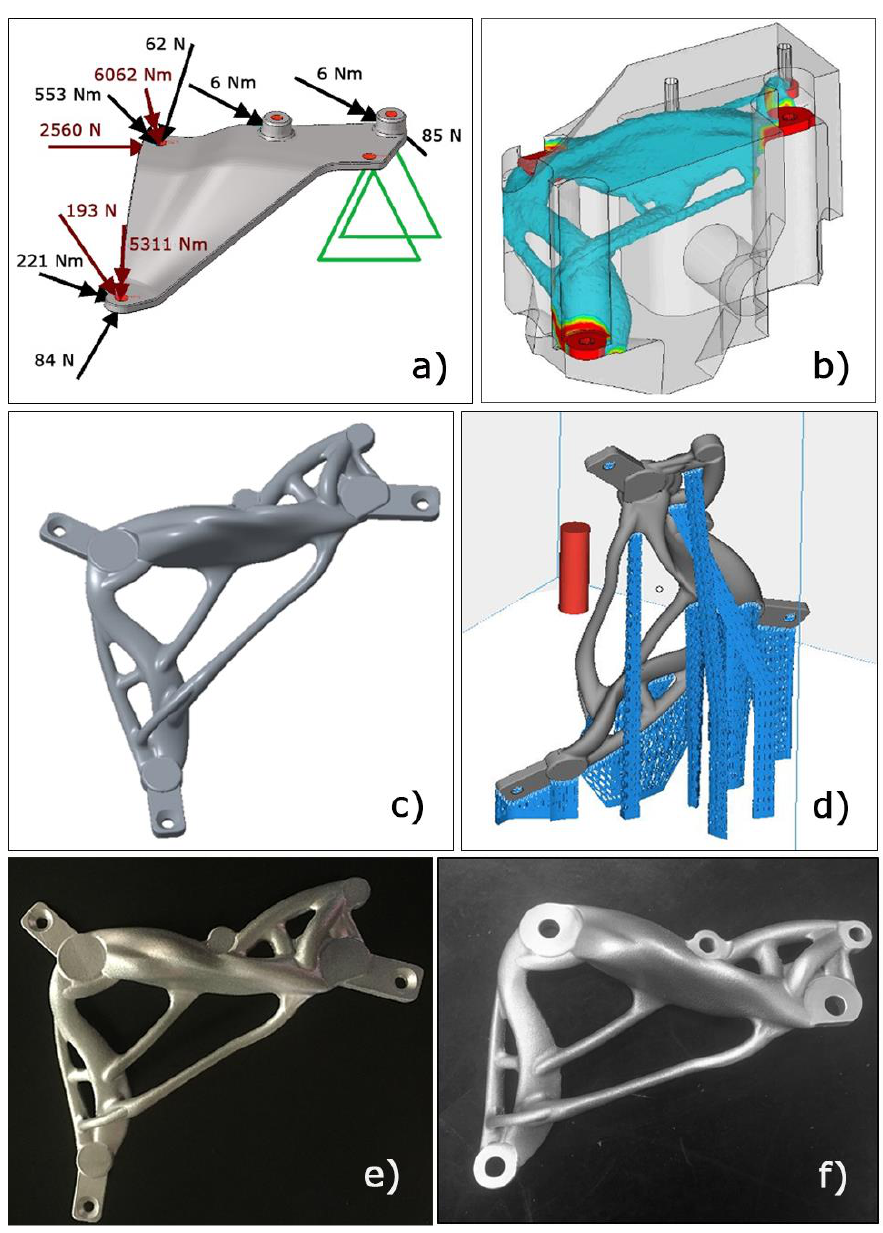
Figure 1. ( a ) Original geometry of the automotive bracket (box dimensions 135 × 80 × 65 mm): the two superimposed static load cases are shown by red and black arrows, the constraints are schematized by the green triangles in fixed points. ( b ) Geometry resulting from the TO of the bracket. ( c ) Final geometry of the stock part with the three appendices added for clamping. ( d ) Industrialized stock part. ( e ) Stock part after LPBF, support removal and shot peening. ( f ) Finished workpiece after